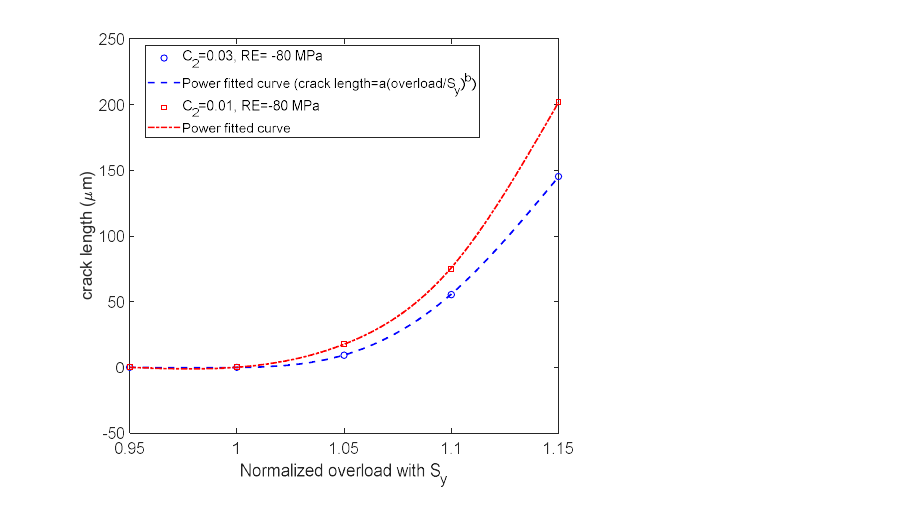
Figure 19. Crack length versus normalized overload values (overload/S y ) with different values of the C 2 parameter: 0.01 and 0.03.